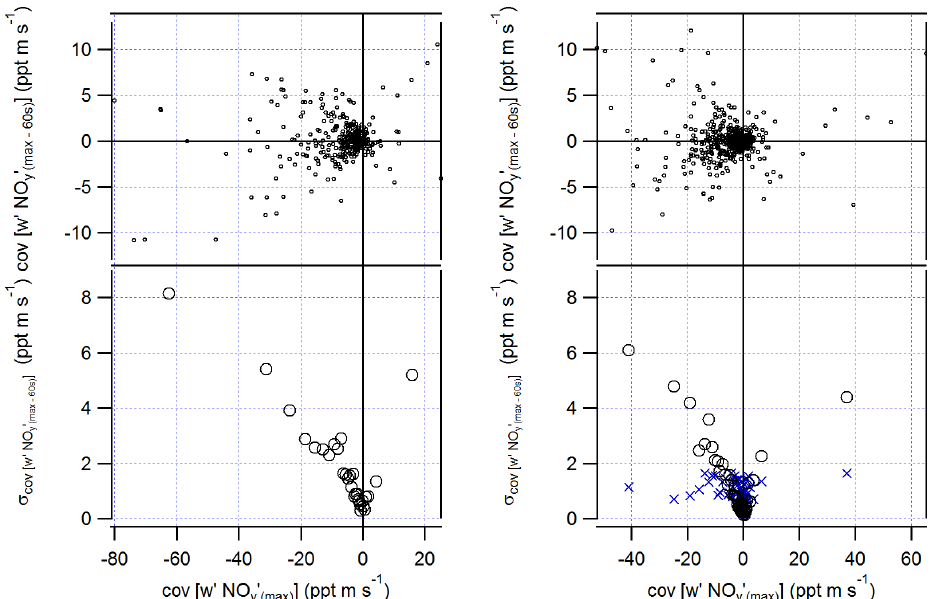
Fig. 4. Uncertainty calculated for half-hour measurements of w 0 NO y 0 . Top panels show the measured “zero” covariance by lagging the sensor wave by 60s, highlighting that these observations are grouped around the zero line. The bottom panels show the standard deviation of equally sized bins of zero measurements as a function of “true” covariance at maximum covariance lag time. Results for PROPHET are shown in (a) , and results from HFWR are shown in (b) , where the “X” markers are the results from the zero air